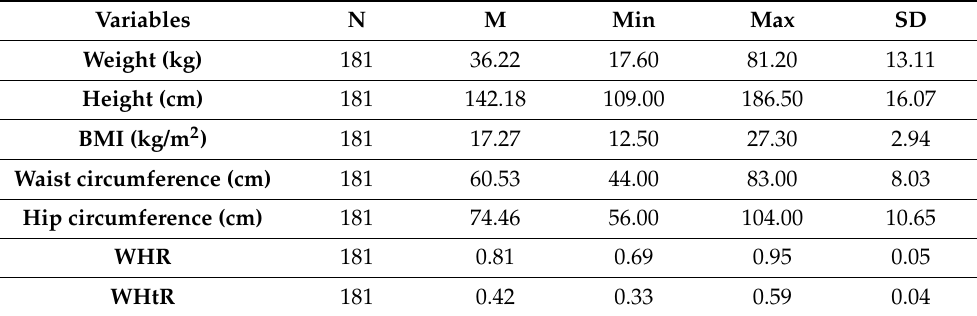
Table 1. Characteristics of the studied population including body weight, body height, BMI, waist circumference, hip circumference, WHR and WHtR.